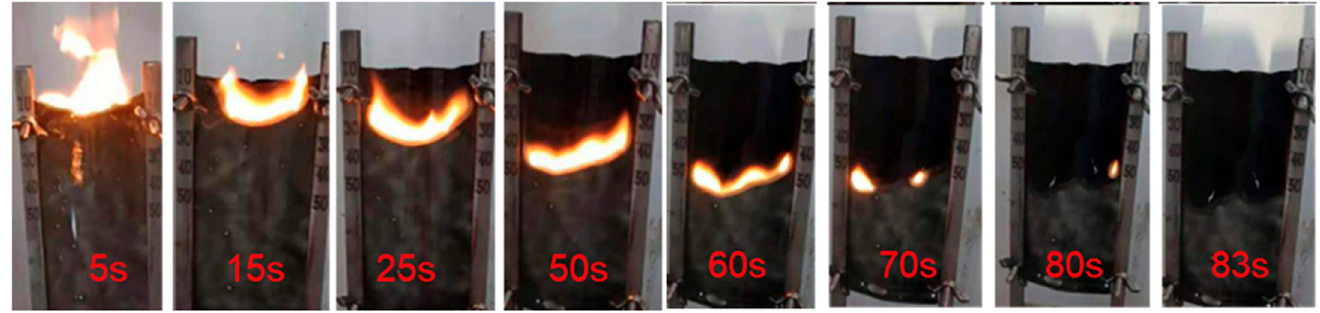
Figure 4. The burning behaviors of MXene 1 . 0% /PVA-PVPA 10% -PEPA 5% during the LOI value =